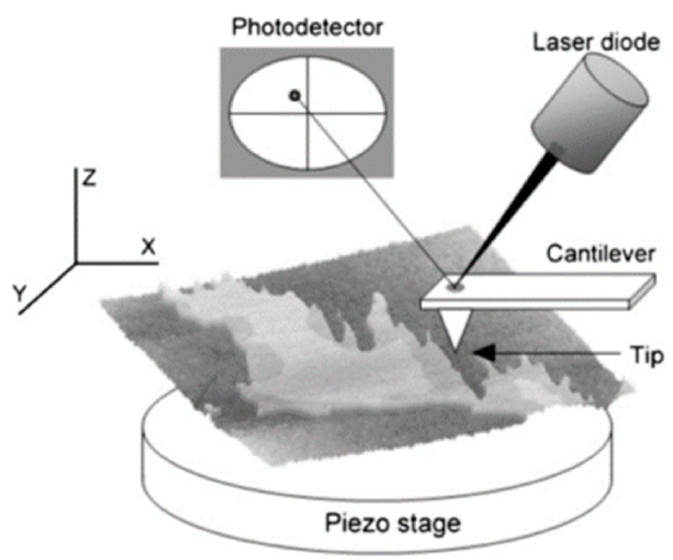
Figure 3. Overview of the basic parts of an AFM. A laser is focused on the tip that reflects the beam towards a photodetector. Tip–surface interactions bend the cantilever, which in turn generates a laser beam displacement. Then, the photodetector and the AFM software transform laser movements into the desired information. From Garcia-Manyes and Sanz [88].